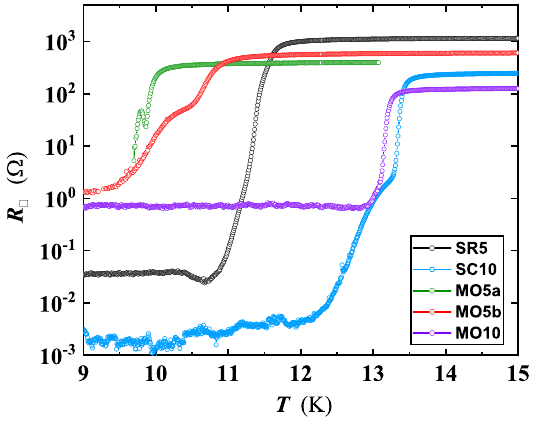
Figure 5. Temperature − dependent sheet resistance of ultrathin NbN films (5 and 10 nm of thickness), deposited on different substrate types, exhibiting quantum effects in 2D. The differences in the curve behavior of MO5a and MO5b (belonging to the same deposition run) are related to specific choices of process parameters during the Hall bar